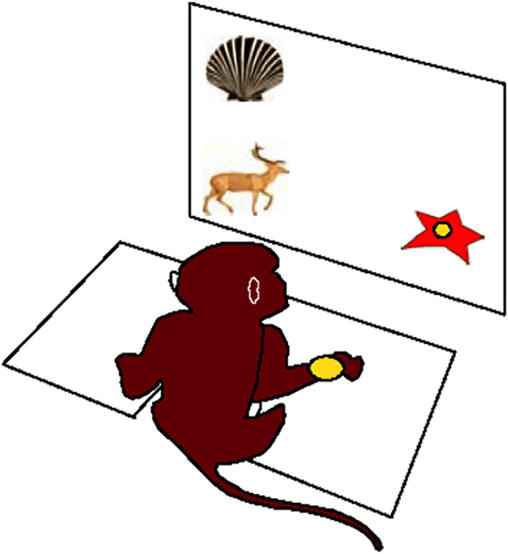
By training monkeys on a classic “match to sample” task, researchers show that ampakine drugs can alleviate the cognitive defects associated with sleep deprivation